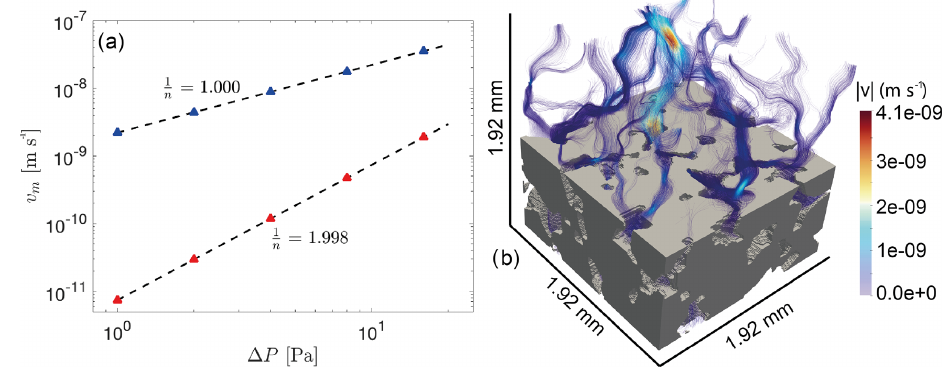
Figure 9. Computed results on the Fontainebleau sample using non-Newtonian rheology. Panel (a) shows the mean velocity against the applied pressure at the top boundary. Red and blue triangles symbolize each simulation, and the corresponding dotted black line represents the fitted curve through the obtained data with slope 1 . Panel (b) illustrates computed streamlines of the Fontainebleau subsample using a n power-law coefficient of 0.5. Solid material is displayed in grey and the streamlines are colored according to computed